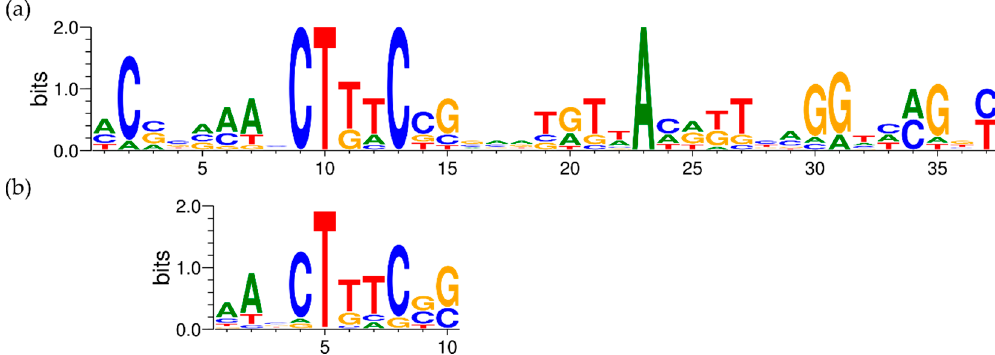
Figure 7. Conserved motifs 5 ′ of the cop cluster pTSSs according to MEME ( a ) and Improbizer ( b ).